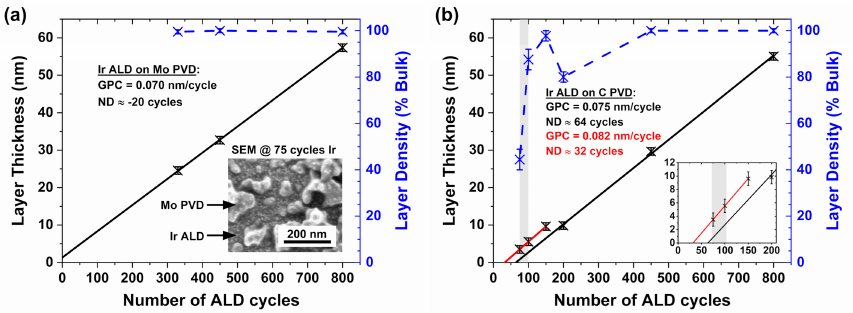
Figure 7. Layer thickness and layer density of Ir coatings depending on the number of ALD cycles on seed layers of ( a ) Mo and ( b ) C. In certain regions, the film growth is fitted linear (black and red lines). The corresponding GPC and ND are indicated. For the Mo seed layers, a top-view SEM image with 75 cycles of Ir is shown. A gray background highlights the region of Ir layer percolation on the C seed